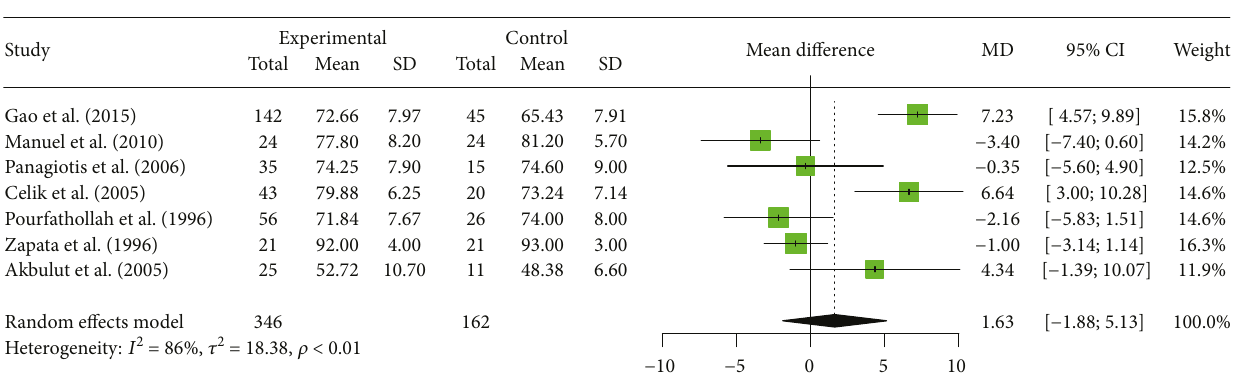
Figure 2: Forest plot of the changes of peripheral blood CD3+ T cell in human brucellosis patients compared with controls. Table 2: The results of CD3+ T cell data sensitivity analysis. In fl uential analysis (random e ff ects model)